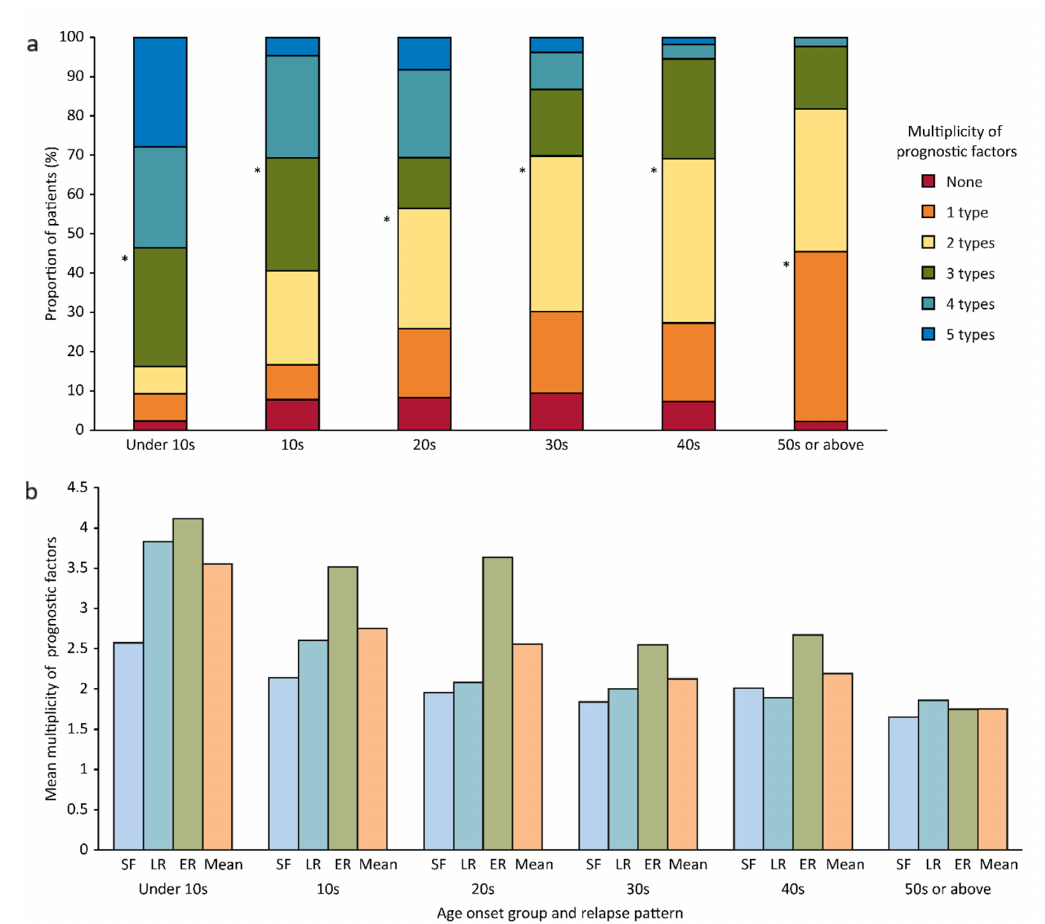
Figure 5. Comparison of the multiplicity ( a ) and mean multiplicity ( b ) of prognostic factors across the age groups stratified by relapse pattern. ( a ) The largest proportion of patients in the group with onset age under 10 years old had three prognostic factors *, namely, a symptom duration > 120 months, no remission within 1 year, and > 10 GTC seizures. In the group with age of onset between 10 and 19 years old, the factors were a symptom duration > 120 months, > 10 GTC seizures, and localization-related epilepsy. In groups with onset at 20–29 years old, 30–39 years old, and 40–49 years old, two prognostic factors were present in the greatest proportion of patients, namely, localization-related epilepsy and relevant lesions on brain MRI scans. However, in the group with onset at age 50 or older, localization-related epilepsy was the most important prognostic factor. ( b ) The mean multiplicities of the prognostic factors showed marginal significance with a decreasing tendency with increasing age. Those in LR and ER patients but not in SF patients showed a significant decreasing